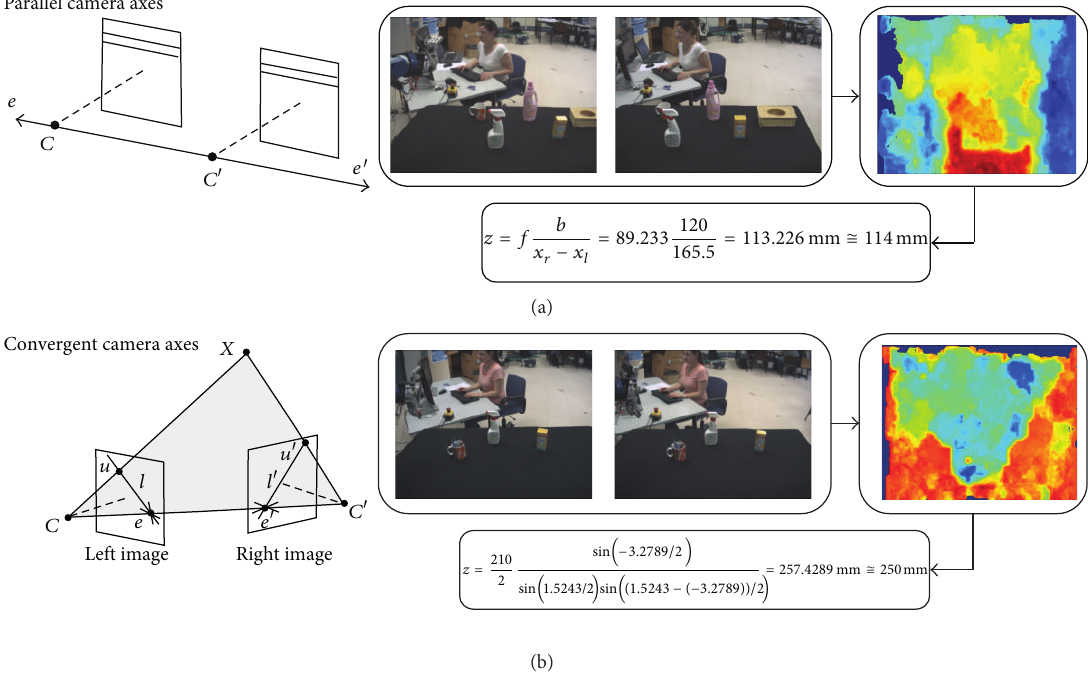
Figure 14: Depth estimation from the disparity maps obtained by the PBBDE approach on the images acquired by a RoboSoft TO40